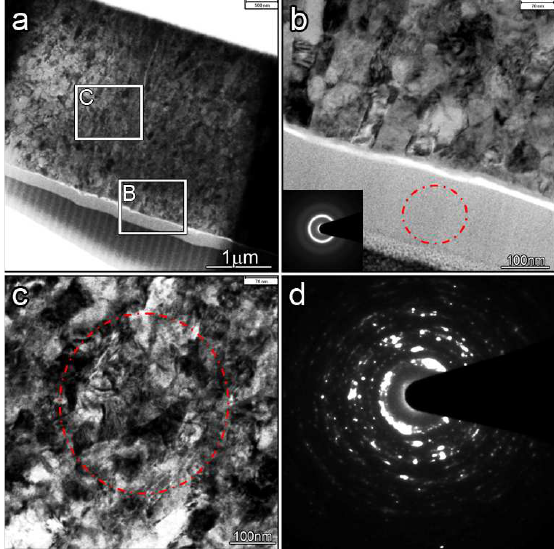
Fig. 6. TEM images of the deformed microstructure in transformed bands formed at a strain of 0.30 and a strain rate of 2300 s -1 : (a) low magnified image; (b) high magnified image in Fig. 6a and zone B; (c) high magnified image in Fig. 6a and zone C; (d) SAED in Fig. 6c.